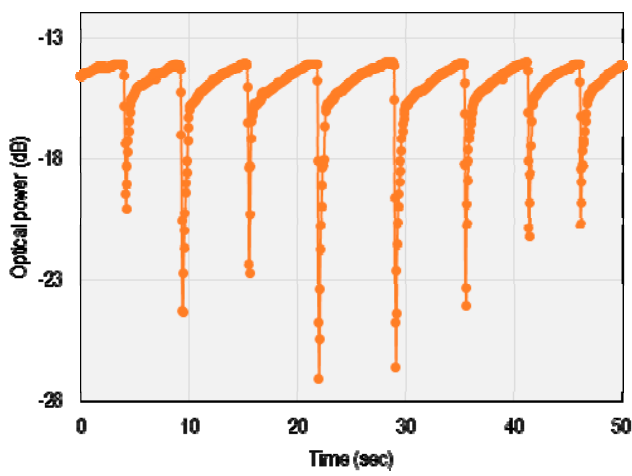
Figure 9. Sensor response to breathing from 10 cm distance with humidity raning from 50% to 100%.